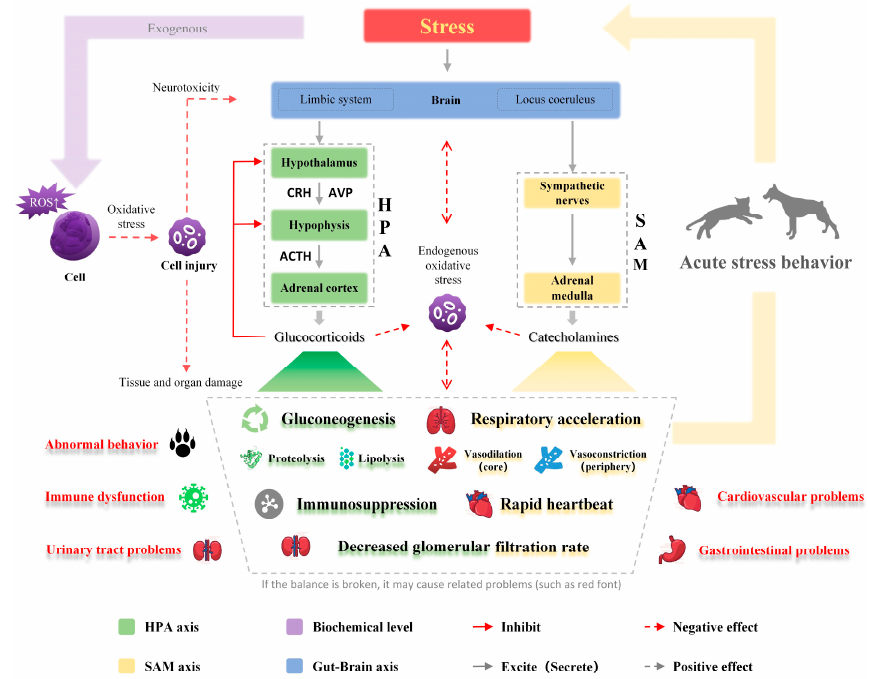
Figure 1. Regulatory mechanism of stress response. The components highlighted in green are mainly affected by the hypothalamus–pituitary–adrenal axis, and those in yellow are mainly affected by the sympathetic–adrenal medulla axis. It is worth noting that only the main impact is presented, and there is a broader and more complex relationship between the two systems. The elements in red indicate the possible harm of stress. Stress can induce oxidative stress to cause ubiquitous damage to cells, tissues, and organs. ROS, reactive oxygen species; CRH, corticotropin-releasing hormone; AVP, arginine vasopressin; ACTH, adrenocorticotropic